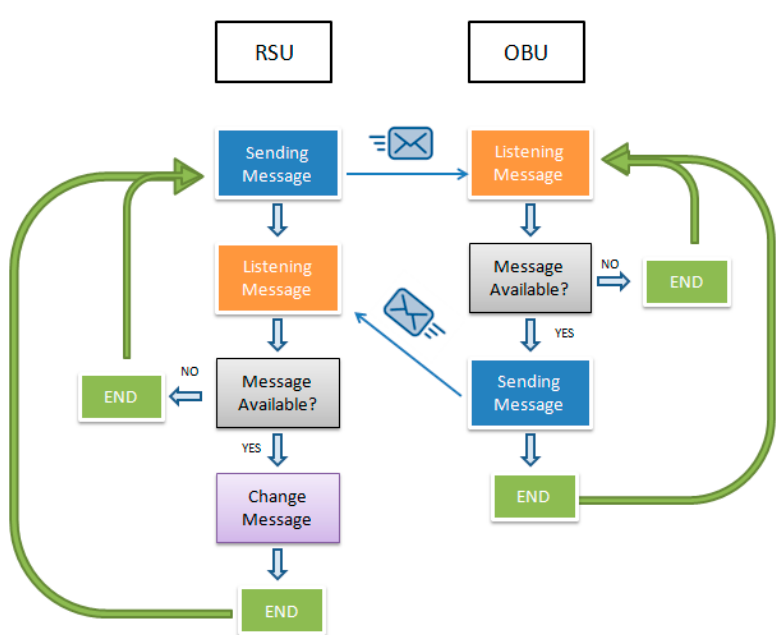
Figure 4. Flow diagram of the algorithm implemented for XBee device with ZigBee protocol.